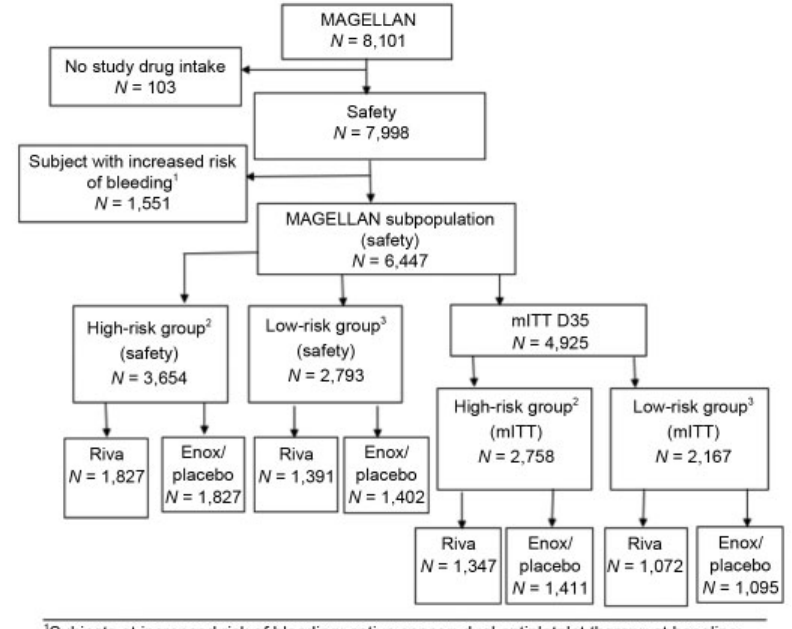
Fig. 1 Subject disposition. mITT, modi fi ed intent to treat; ULN, upper limit of